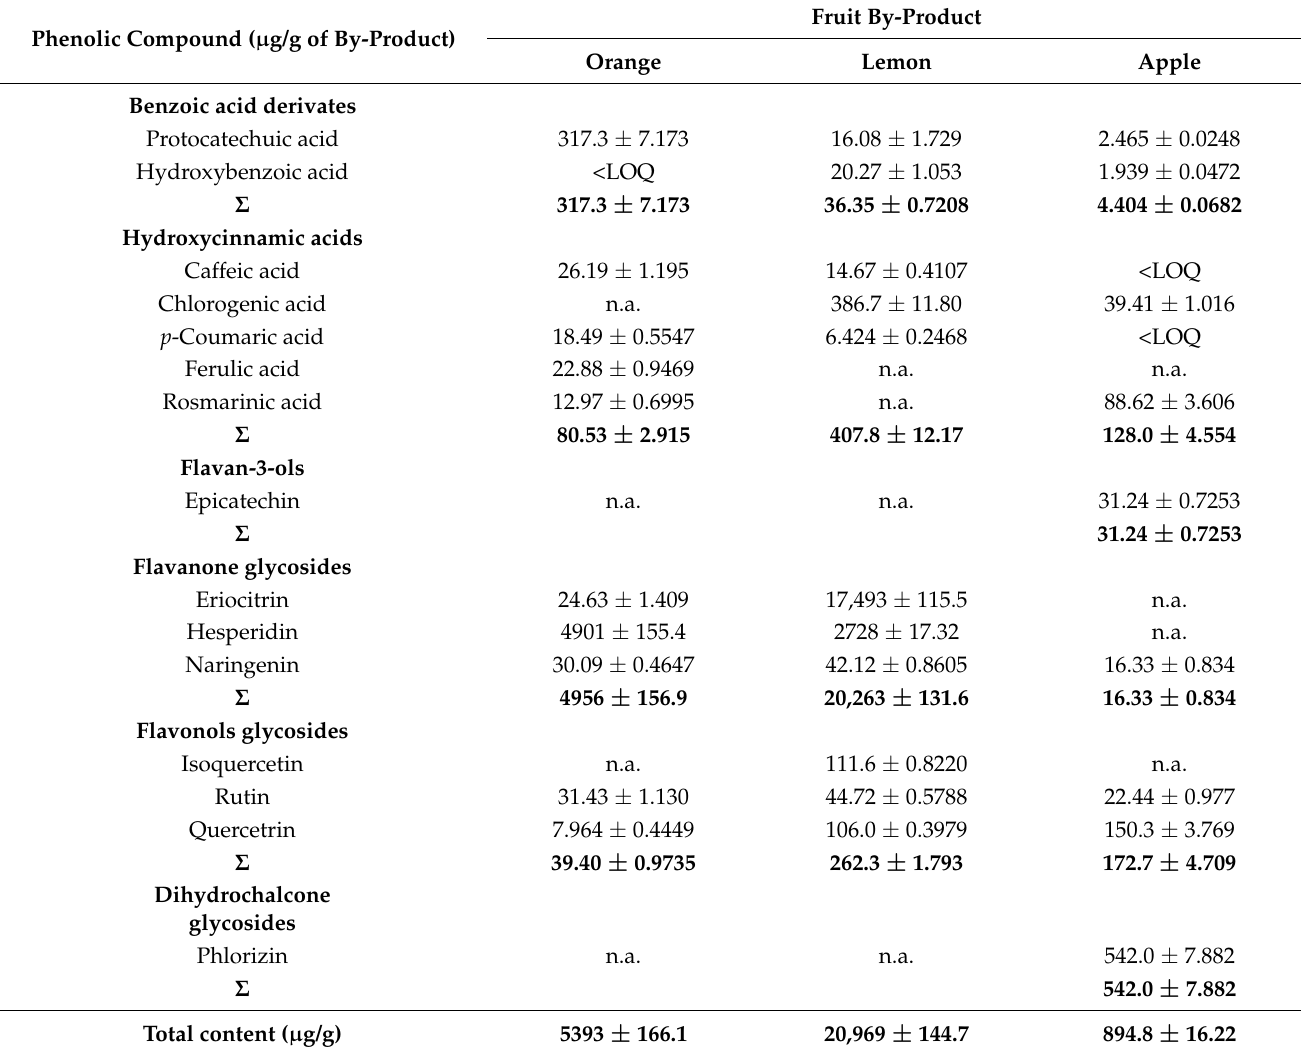
Table 5. Total and individual phenolic compounds contents ( µ g/g dry basis) in the by-products from orange, lemon and apple fruits determined by